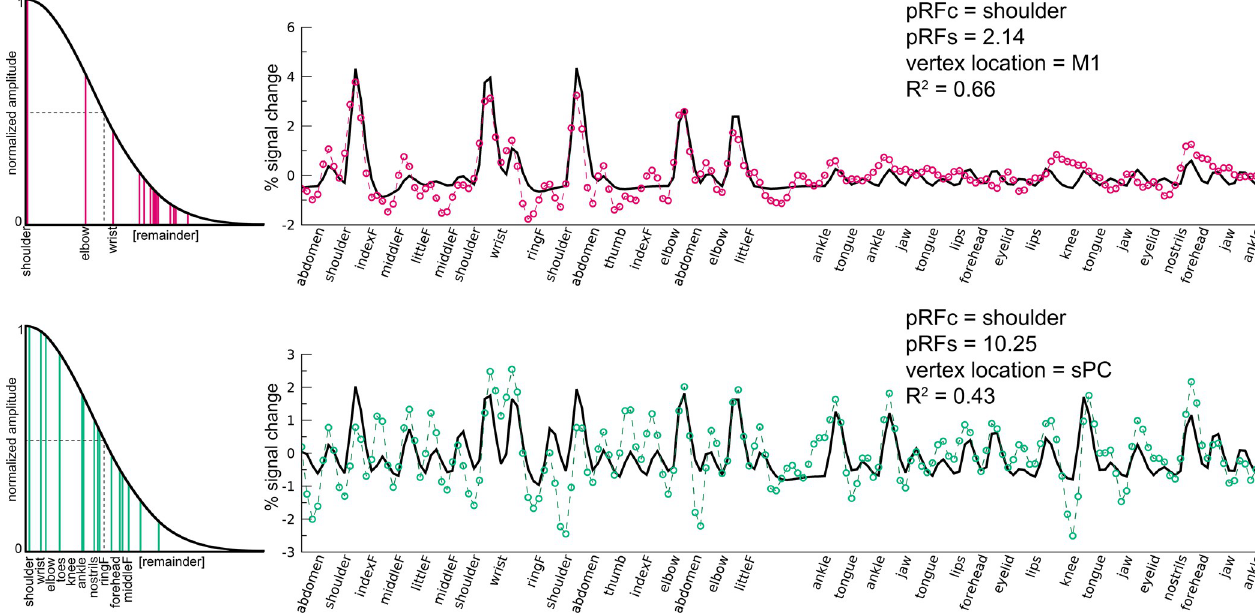
Fig 11. Non-rigid pRF timeseries. The non-rigid pRF fit (black line) with the timeseries of 2 surface vertices (colored dashed lines) are shown for 1 participant (#6) in the upper and lower panels. Movement cues over time are presented at the horizontal axis. On the right, the fit of body parts within the static Gaussian response field is shown, used to construct the timeseries fit. The FWHM/2 within the static Gaussian response field is depicted by the black dashed line. The pRF size is determined on the number and spread of fitted body parts (mentioned on the horizontal axis) within the FWHM/2.